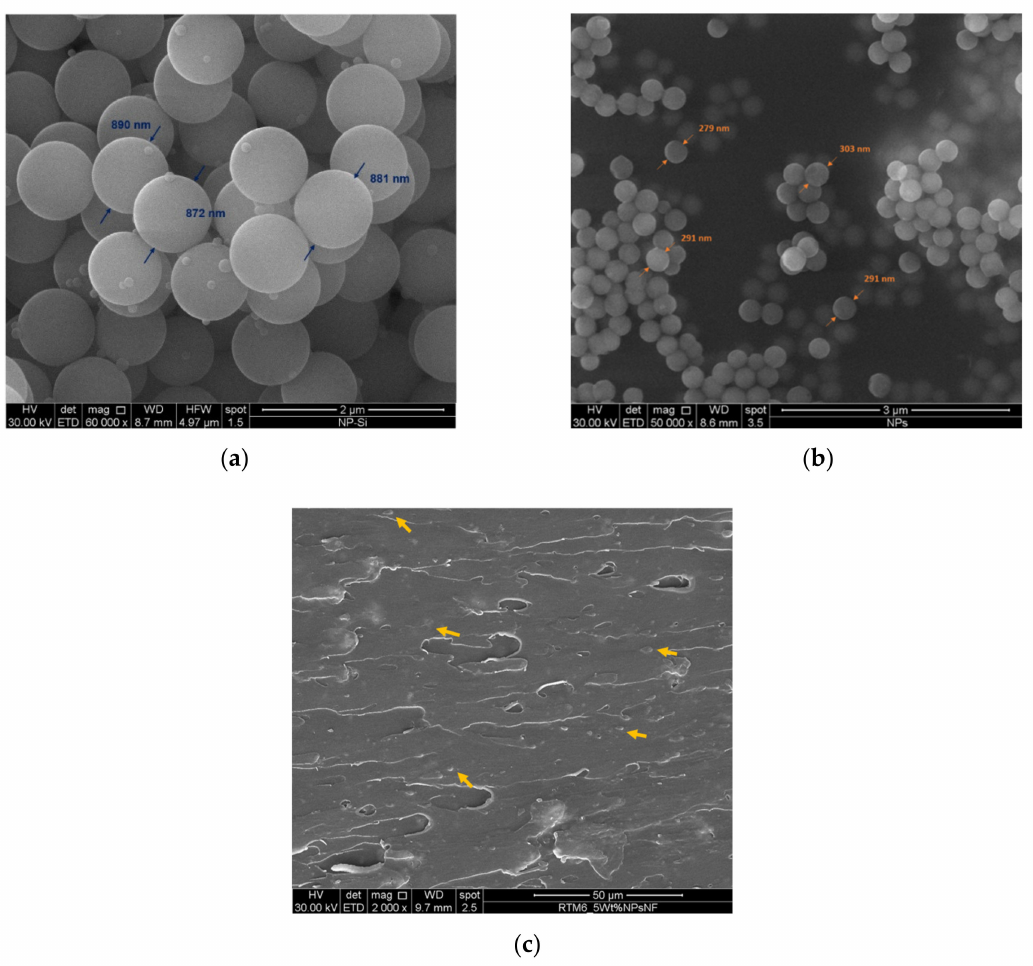
Figure 2. SEM images of the synthesized silica nanoparticles: ( a ) non-functionalized, ( b ) functionalized and ( c ) non- functionalized nanoparticles (indicated by arrows) at 5% weight content in the RTM6 epoxy